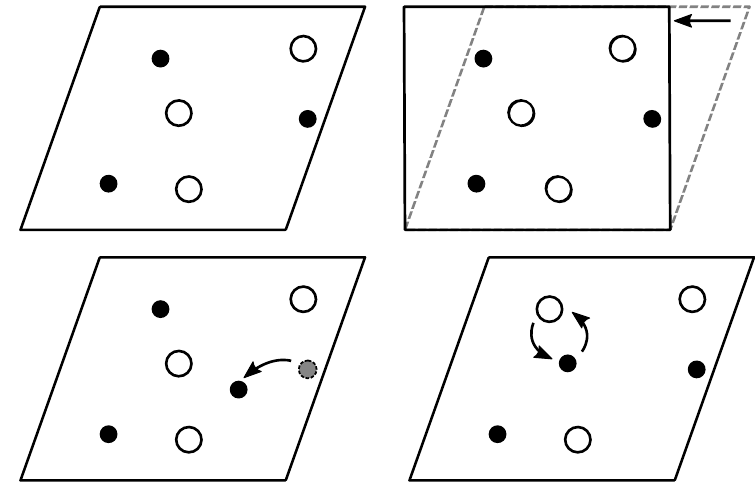
Figure 3. Example of mutation operations on one of the child structures from Figure 2. The original cell ( top left ) can be mutated by: changing the cell vectors ( top right ); perturbing the atomic positions ( bottom left ); or permuting the atoms ( bottom right